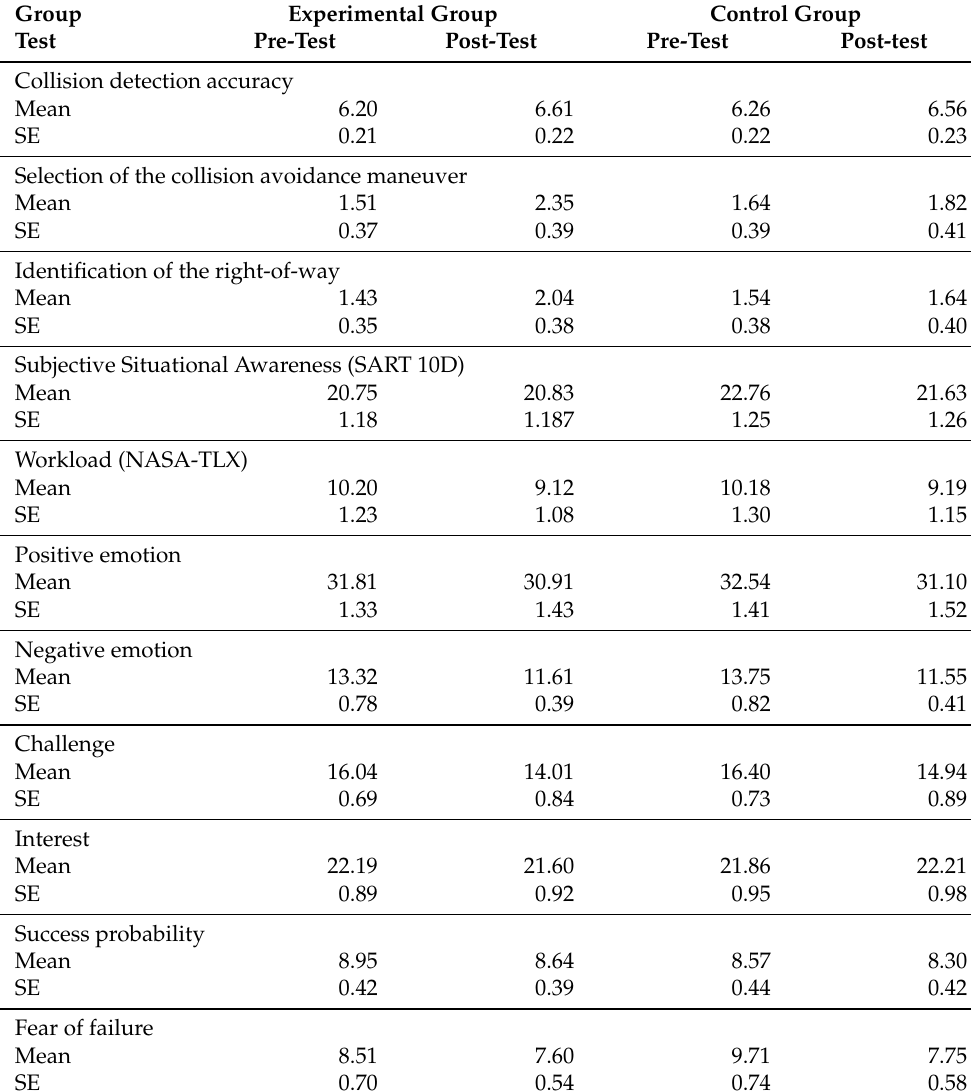
Table 2. Descriptive data of trainees’ performance, situational awareness, workload, emotion and motivation in post-test and pre-test (SE—Standard